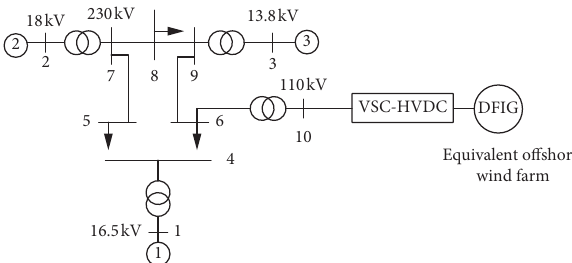
Figure 4: Schematic diagram of the equivalent offshore wind farm connected to the IEEE9 system by